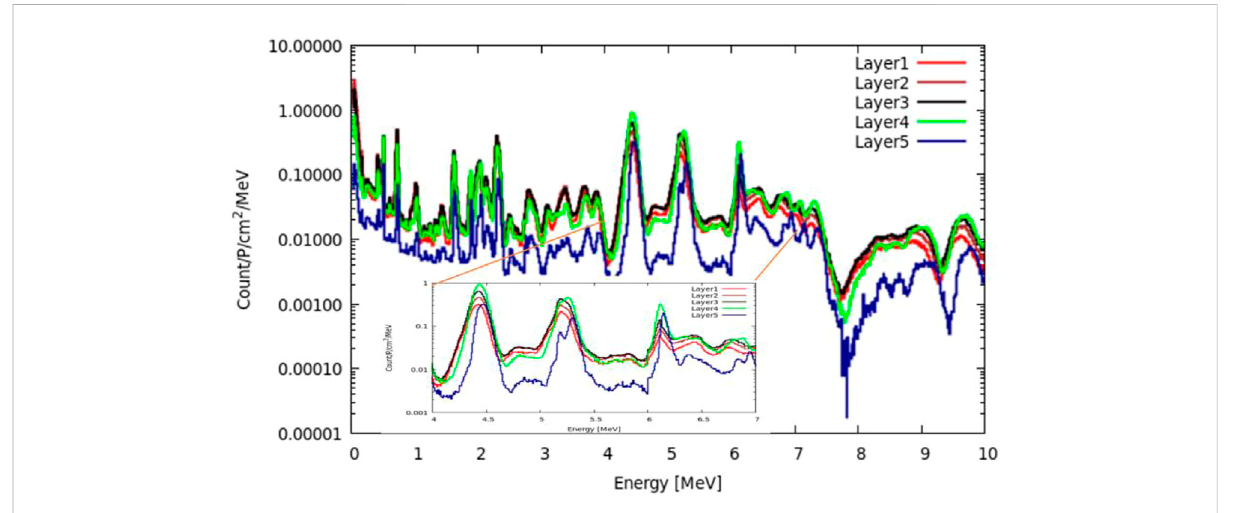
FIGURE 9 Gamma spectra at different